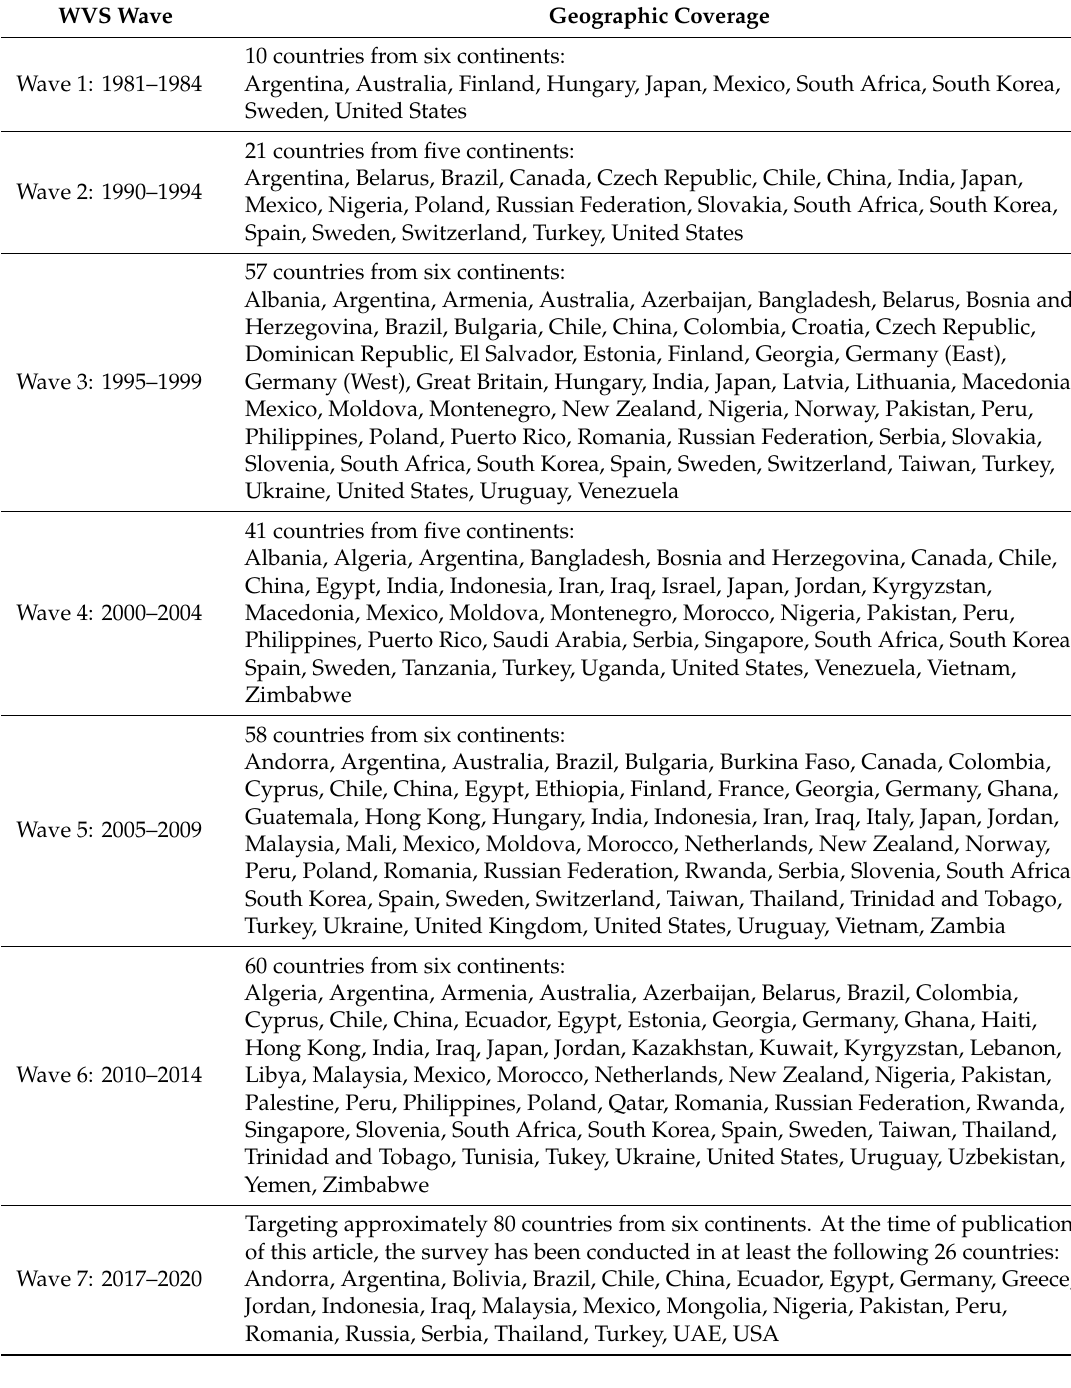
Table 2. Geographic coverage of the seven World Values Survey (WVS)